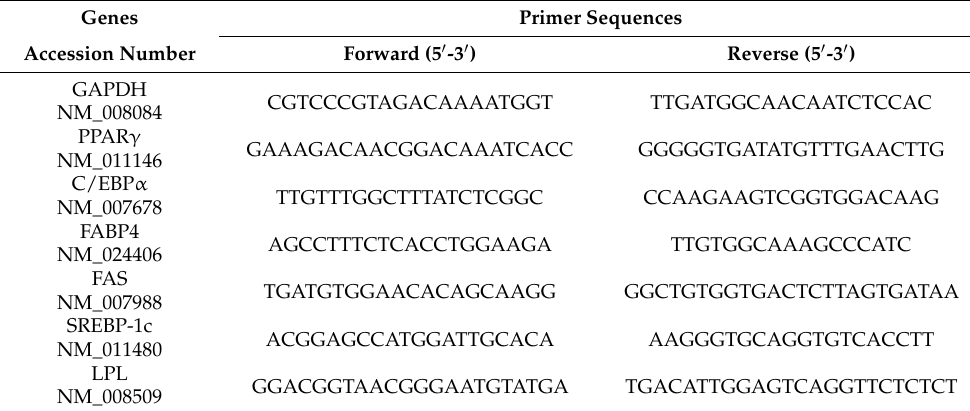
Table 4. Primer for real-time quantitative PCR.